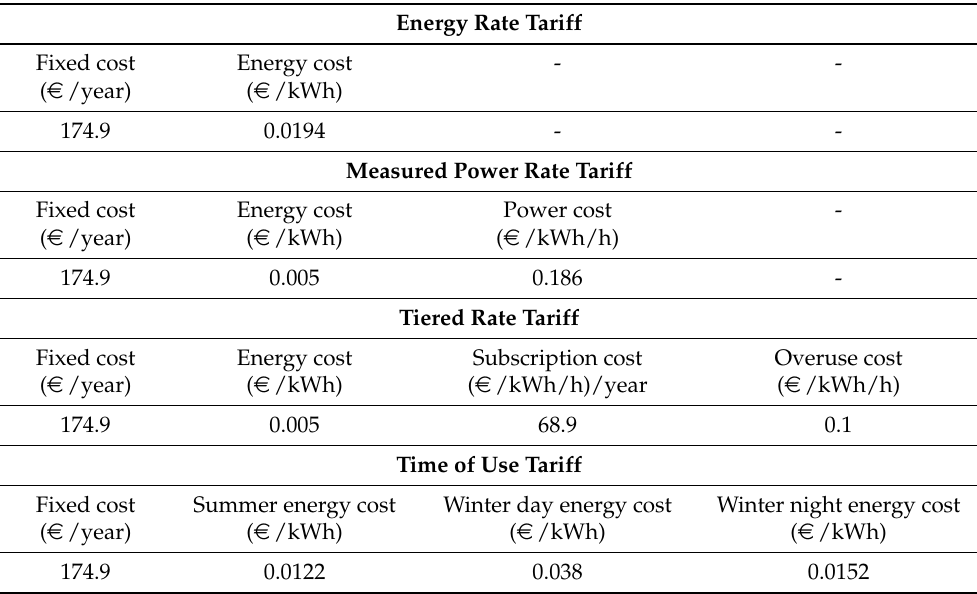
Table 1. Grid tariff rents for residential buildings in the energy rate tariff, measured power tariff, tiered rate tariff, and time of use